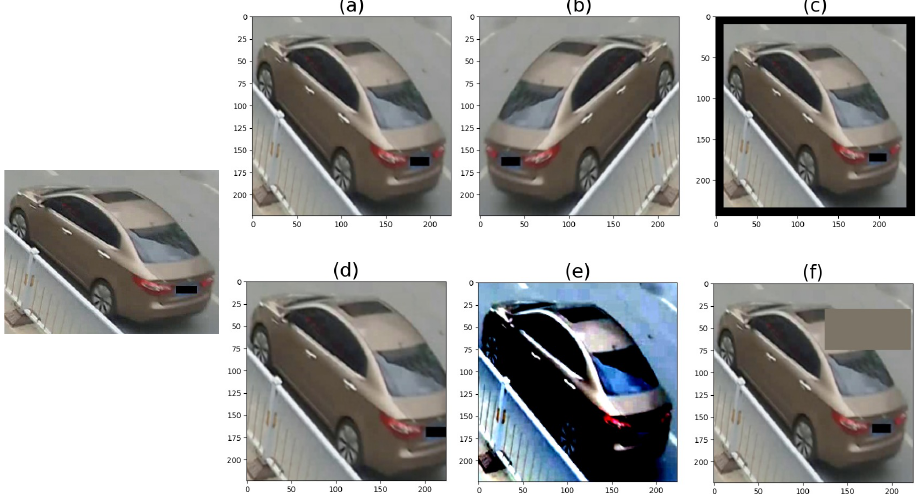
Figure 10. Samples of data augmentation methods: input ( left ), resizing ( a ), horizontal flipping ( b ), padding ( c ), random cropping and resizing ( d ), normalizing ( e ), and random erasing ( f